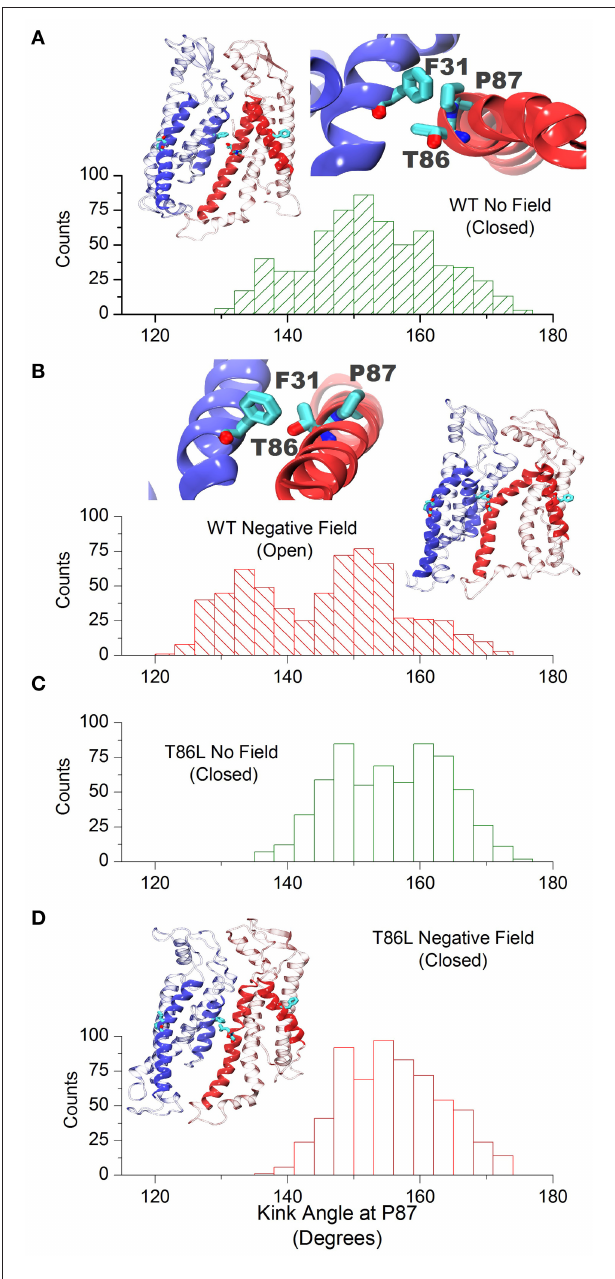
FIGURE 7 | Cx26 in the open conformation. (A) Angle distribution of the kink at TM2 in the closed hemichannel in absence of electric field measured along the last µ s of simulation. The molecular drawings show two adjacent backmapped connexins (left) and the interaction between Phe31, Thr86, and Pro87 looking from the extracellular side (right). (B) Same as (A) for the open configuration. (C,D) Angle distribution of the kink at TM2 for the Thr86Leu mutated Cx26 in the absence and presence of a polarizing field, respectively. The molecular drawing in (D) corresponds to backmapped, mutated connexins (to be compared with those in A,B